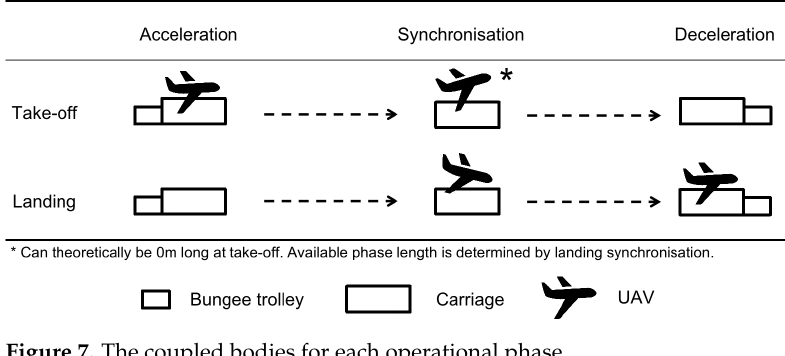
Figure 7. The coupled bodies for each operational phase. Table 1. The associated force and mass parameters for each phase of